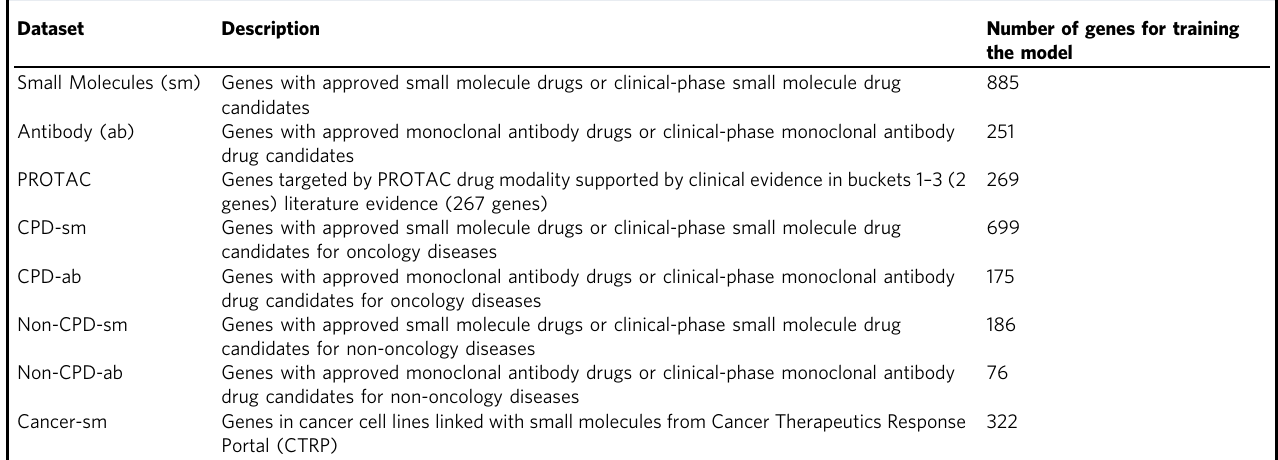
Table 4 Datasets for specialised models.